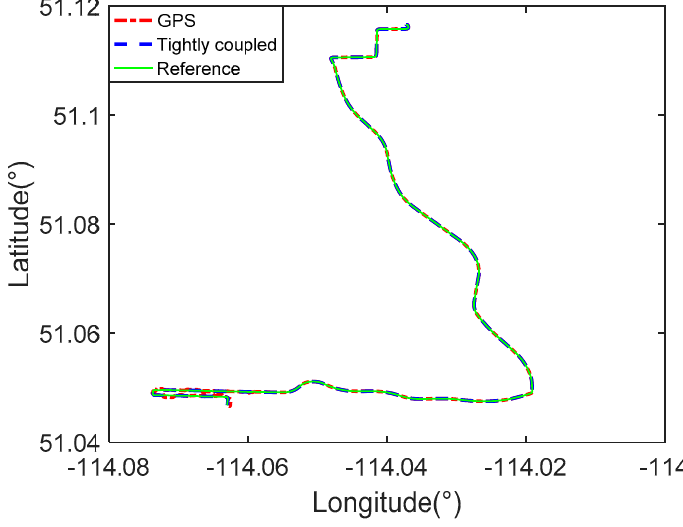
Figure 11. The trajectories of the three results.